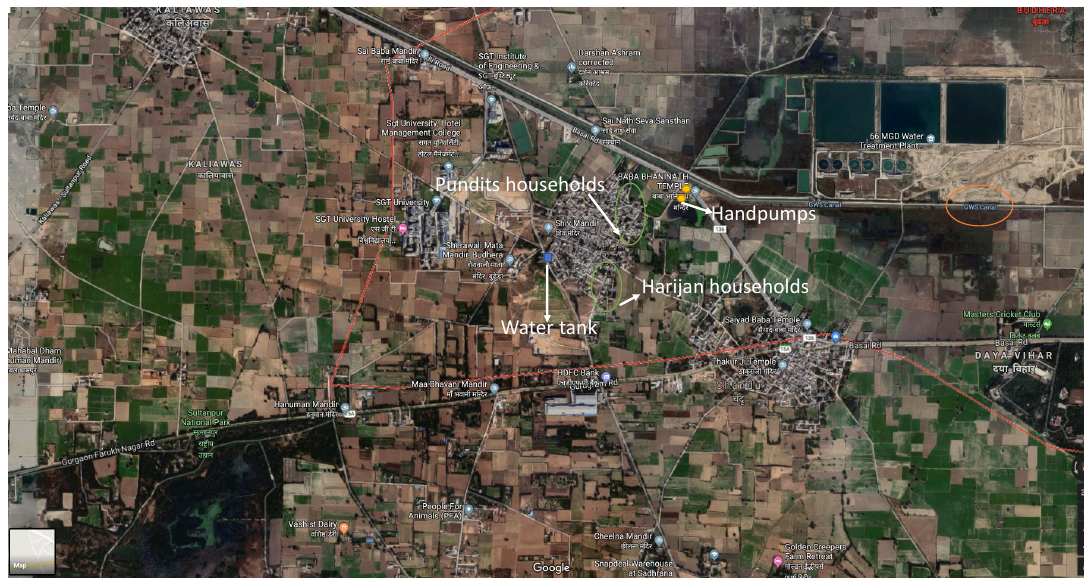
Figure 1. Map of village and key water sources; Source: Google maps.